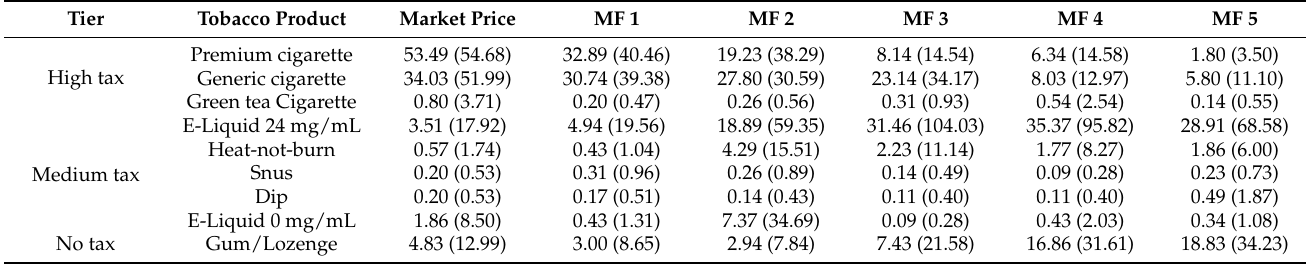
Table A3. Group mean and standard deviation of purchased tobacco products across trials in the harm reduction tax proposal.